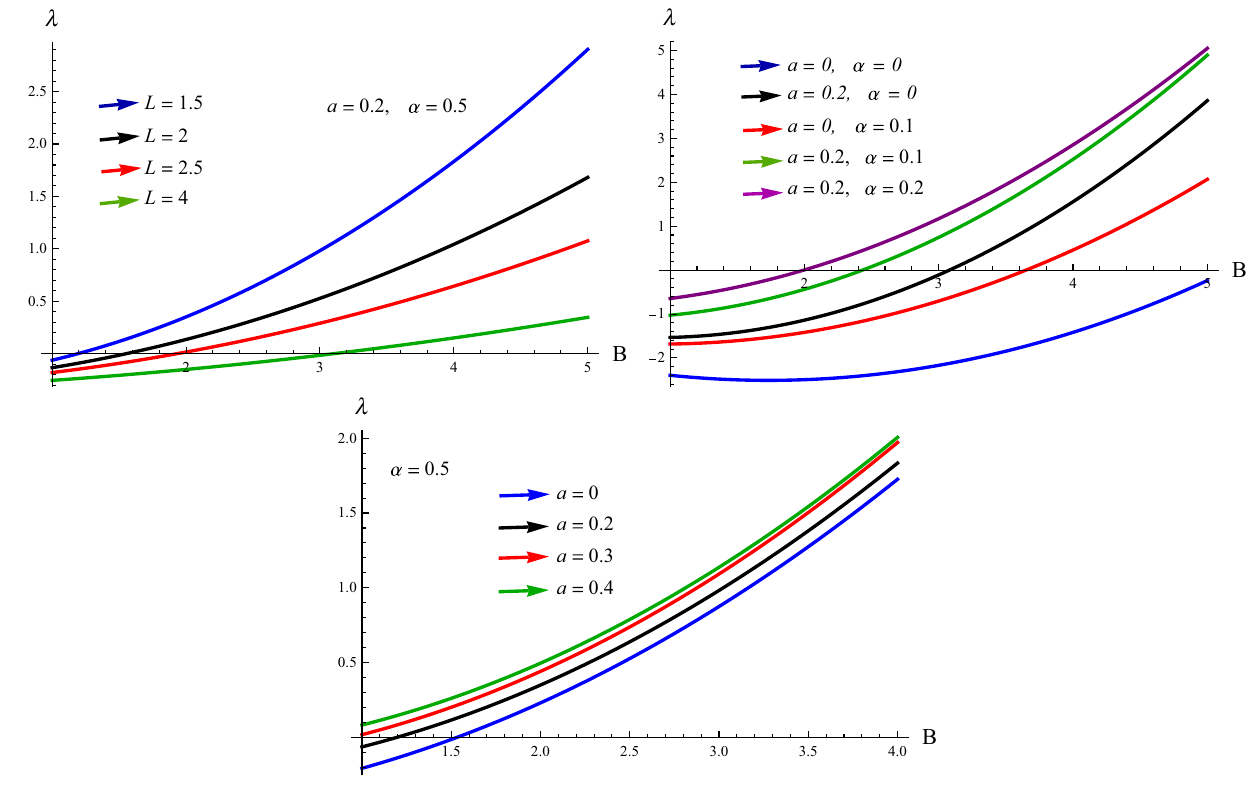
Fig. 4 Lyapunov exponent as a function of B for L = 1 .